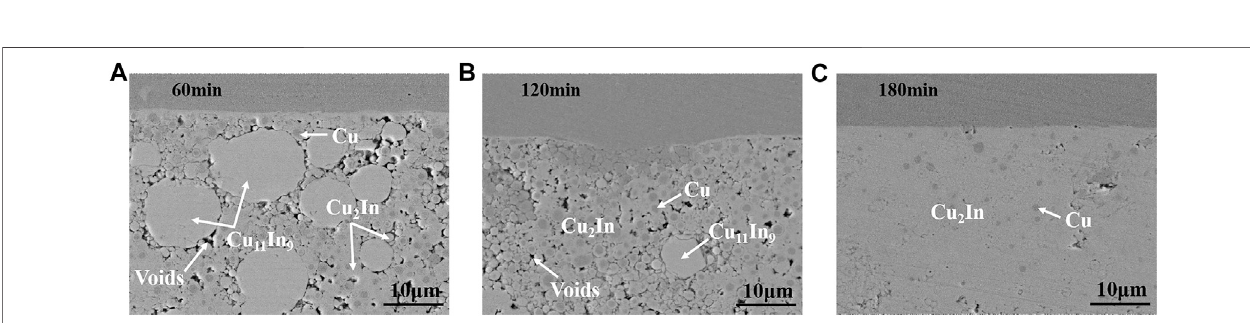
FIGURE 5 | Porosity and shear strength of Cu-In TLPS joints under different bonding pressures at (A) 260 ° C and (B) 320 ° C.